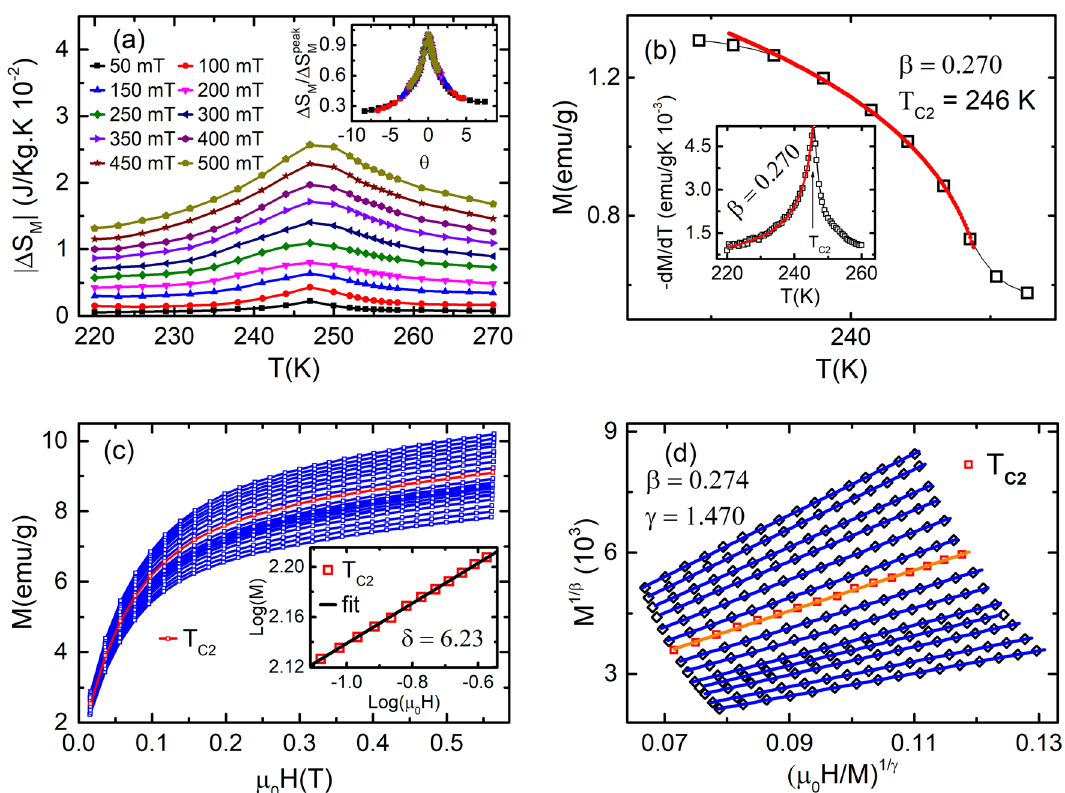
Figure 7. ( a ) Magnetic entropy change (cid:31) S M versus temperature T at different applied magnetic fields varying from 50 to 500 mT, plotted using M-H curve of ( c ). This shows a continuous non-monotonic change of (cid:31) S M around T C 2 . Inset is normalized entropy change as a function of θ . All the curves collapse on a single universal curve for the second-order phase transition. ( b ) M-T around T C 2 for temperature range 220–280 K. Inset is the derivative of magnetization having a transition at T C 2 . Its fitting with Eq. (8) gives β = 0.270. ( c ) M-H for applied magnetic field ranging from 0 to 0.6 T in the temperature range 223–270 K in the step of 3 K. Inset is the log – log plot of the M-H at T C 2 with fitting the log of Eq. (7), which gives the value of exponent δ = 6.230. ( d ) MAPs of BL-LSMO-0.3 show linear behavior in higher applied field, with the plot at T C 2 seems to passing through the origin.